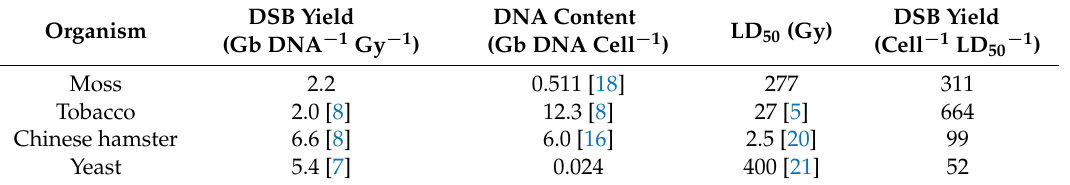
Table 1. DNAdouble-strandbreak(DSB)yieldsandradiosensitivityinthemoss P.patens